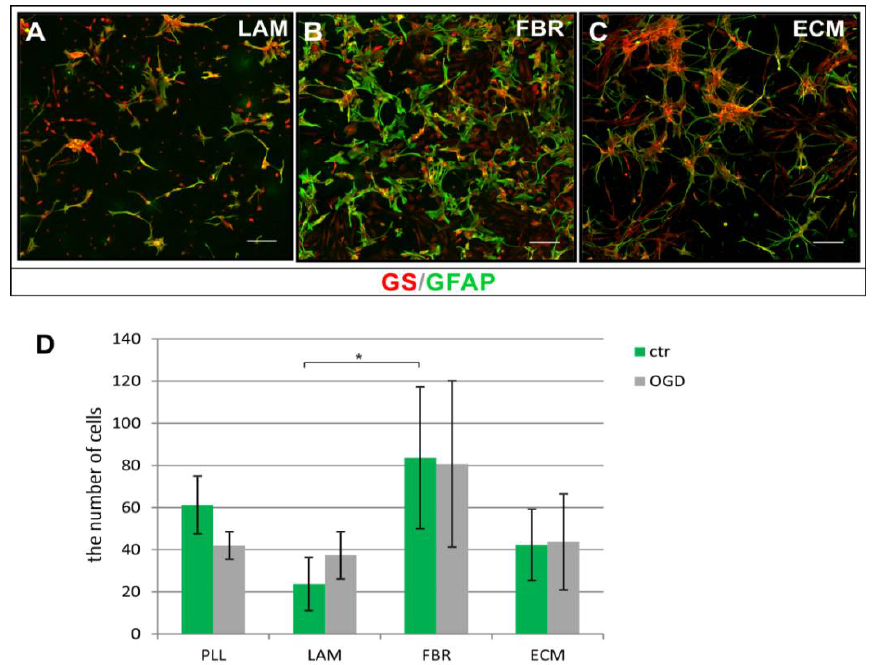
Figure 6. Neonatal rat astrocytes (GS + /GFAP + ) cultured on surfaces covered with different biomolecules: laminin ( A ), fibronectin ( B ), and Extracellular Matrix components ( C ). Culture density depends on diversified adhesive properties of the applied biomaterials and is the highest when astrocytes are cultured on fibronectin. Cell nuclei are stained with Hoechst dye (blue). Scale bar represents 50 µ m. ( D ) Number of cultured astrocytes in regard to molecules used for coating culture surfaces . * p < 0.05